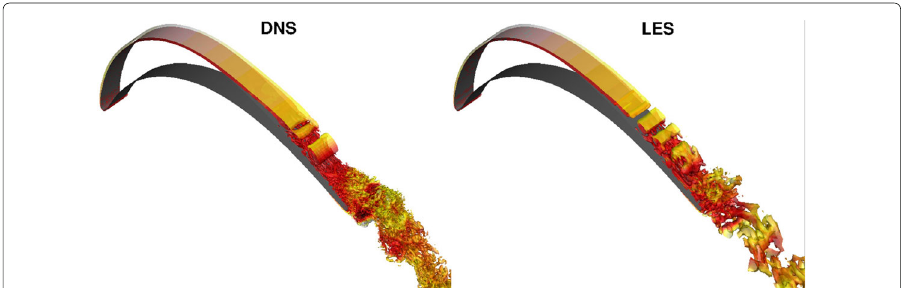
Fig. 10 Instantaneous Q-criterion contours colored by the axial velocity. The DNS solution consists of 9.5M DOF using a p3 discretization on the fine mesh whereas the LES consists of 0.5M DOF using a p2 discretization on the coarse